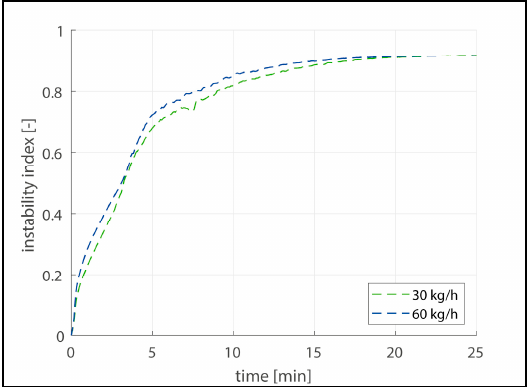
Figure 5 . Instability index of the two artificial laboratory emulsions. Average from six measurements.